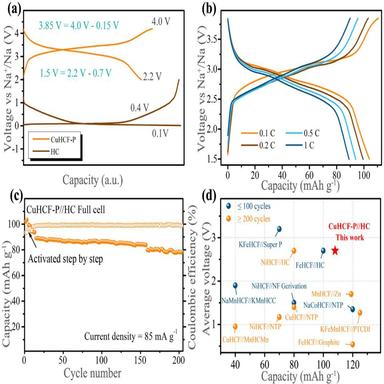
(a) The charge/discharge galvanostatic curves of CuHCF-P/Na, and HC/Na half-cells. (b) The full-cell charge-discharge curves at various rates (1 C = 85 mA g−1). (c) Long-cycle performance of CuHCF-P/HC full cells, and (d) comparison of PBAs full-cells (specific capacity calculated by active mass of cathodes).